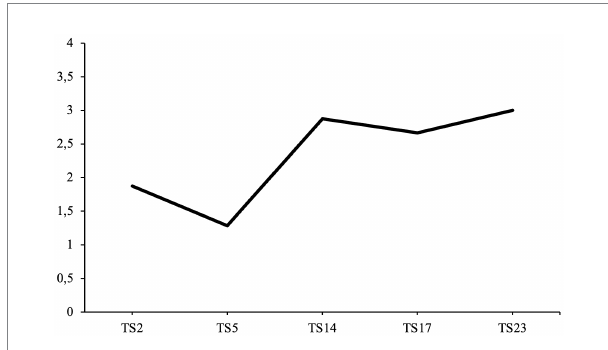
FIGURE 4 Average agency scores over the course of treatment. TS, therapy session.